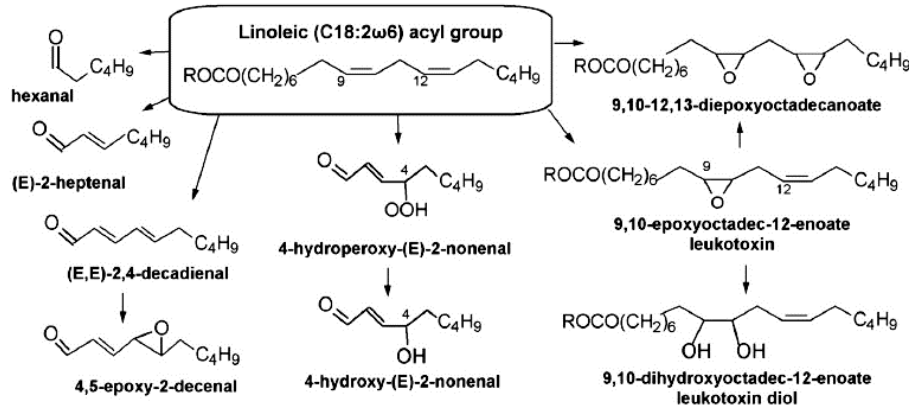
Figure 33. Some of the secondary or further oxidation compounds derived from linoleic acyl groups that can be detected by 1 H-NMR. Adopted, with permission, from [26]. Copyright 2014, Institute of Food Technologists.